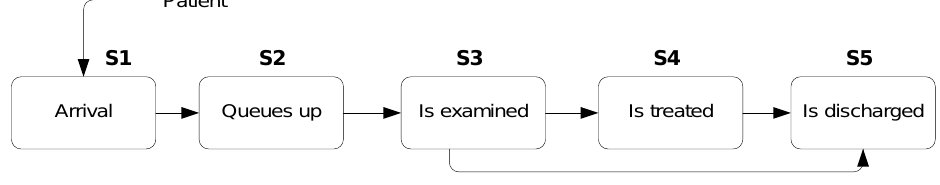
Figure 1. Various Patient states